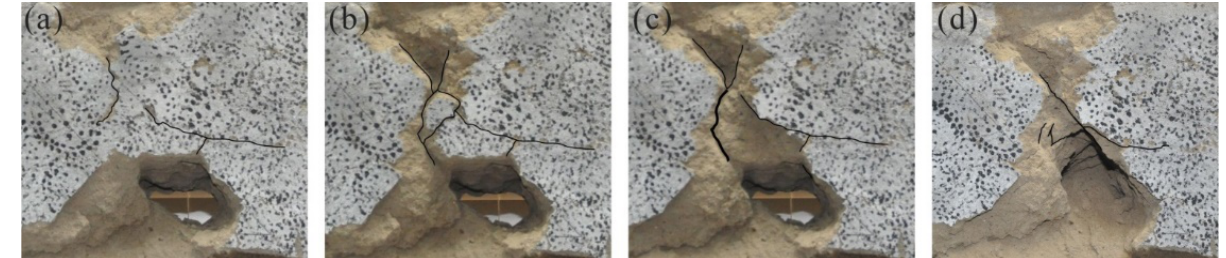
Figure 5. The entire process of the deformation and failure of the overlying strata. ( a ) Tensile cracks on the top of the goaf; ( b ) Cracks expanding; ( c ) Deterioration of the cracks; ( d ) Roof caving. The stress field in the rock mass was in equilibrium before being disturbed by